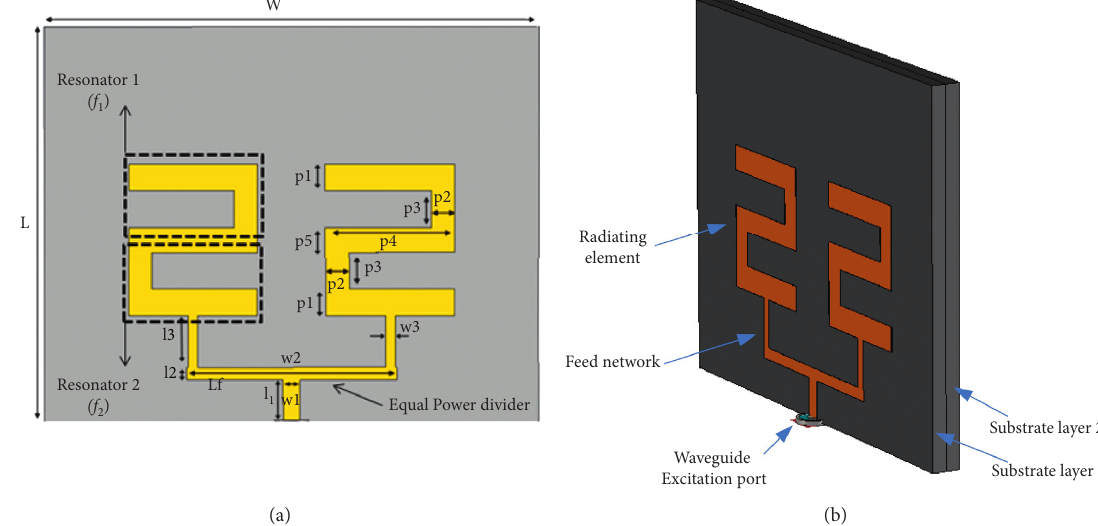
Figure 2: Layout of the proposed two-element MD array with (a) the physical parameters label and (b) substrate position.